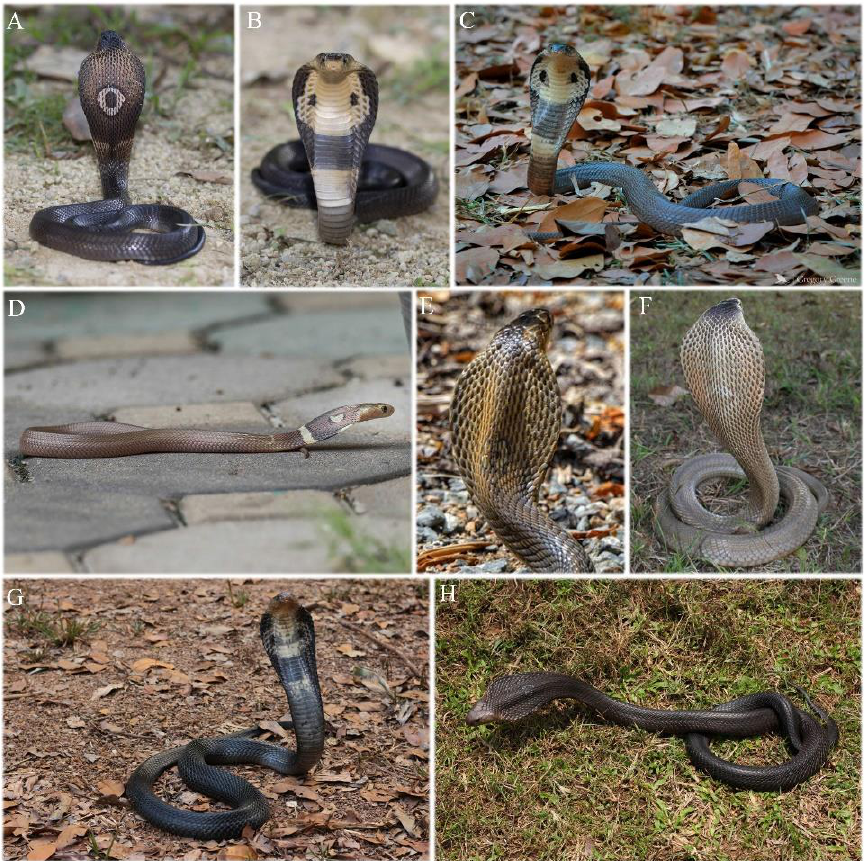
Figure 8. Southeastern Asian Naja kaouthia in life. ( A , B ) a juvenile from Selangor, Peninsular Malaysia; ( C ) an adult from Chang Wat Nakhon Ratchasima, Thailand; ( D ) a juvenile from Samut Prakan, Thailand; ( E ) an adult from Surat Thani, Thailand; ( F ) an adult from Ranong, Thailand; ( G , H ) two adults from Duc Trong, Lam Dong, Vietnam. ( A ) was photographed by Dr. Teo Eng Wah. Other photos were cited from iNaturalist.org occurrence dataset https://doi.org/10.15468/ab3s5x via GBIF.org (licensed under http://creativecommons.org/licenses/by‑nc/4.0/) by following photographer: Gregory Greene (( C ) record No. 2006052432), Wich’yanan L (( D ) record No. 3090707753), Mintkhaosok (( E ) record No. 3325726349), Knotsnake (( F ) record No. 3384192379), Herpingvietnam (( G ) record No. 2557801804), Leonid A. Neymark (( H ) record No. 2366151765). Distribution. South Asian clade: Northeastern India, Nepal, Bhutan, southern Xi‑ zang Autonomous Region (Tibet) of China, Bangladesh. Southeastern Asian clade: South‑ ern Myanmar, central and southern Thailand, Cambodia, central and southern Laos, south‑ ern Vietnam, Malay